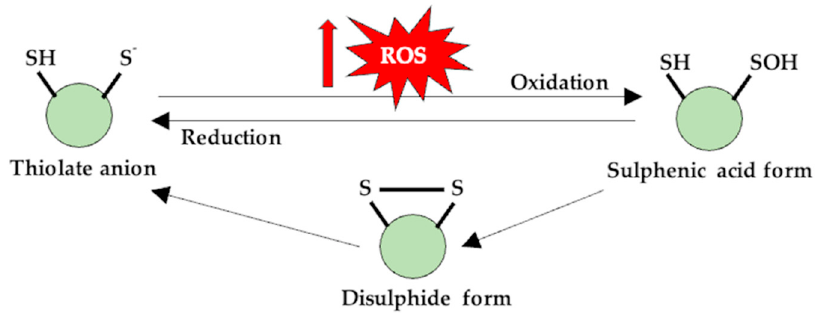
Figure 1. Thiol (-SH) groups are susceptible to redox reactions, and at physiological pH values, they are found in an anionic form. The oxidation of this form generates a sulfenic derivative, which can reverse to its initial form through the disulfidic form, and, in this case, the protein can change its functionality.